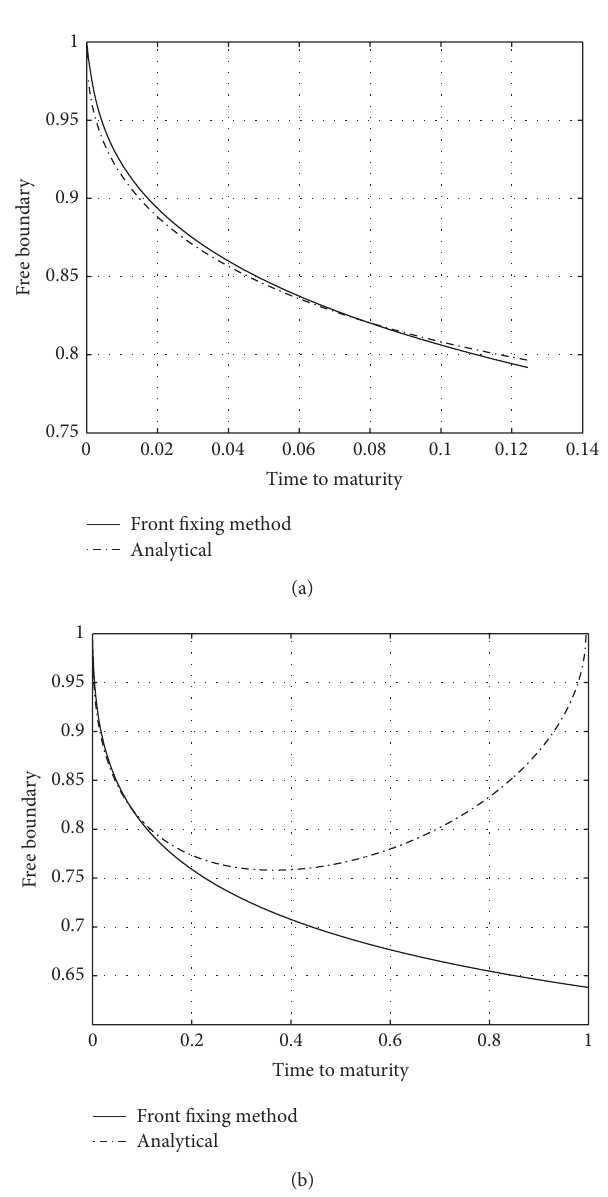
Figure 3: Comparison with the analytical approximation of Kuske close to 𝜏 = 0 (a) and for [0, 𝑇]